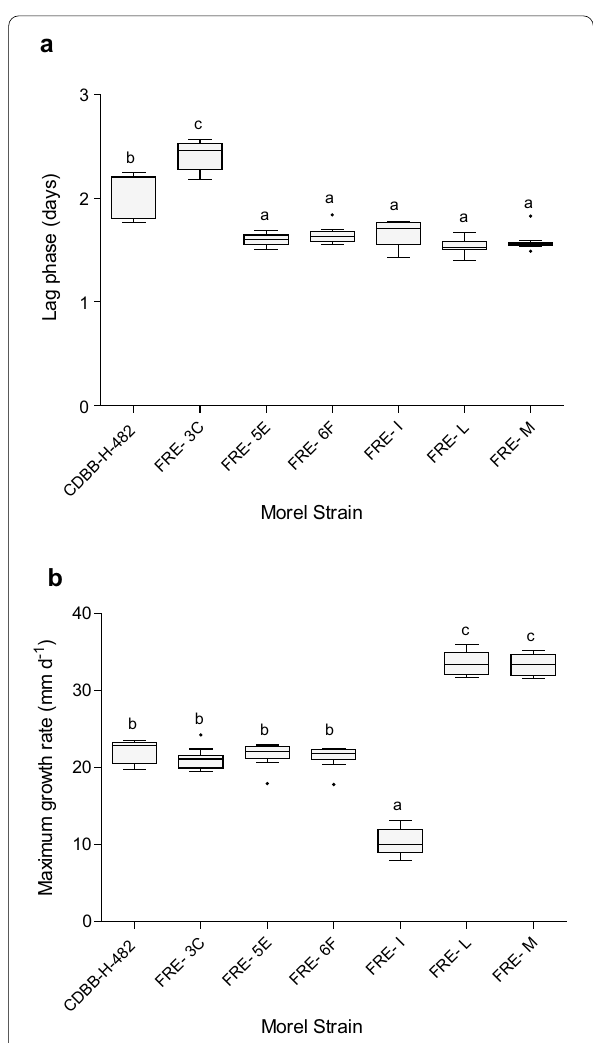
Fig. 5 a Lag phase of M. esculenta CDBB‑H‑482 and Morchella sp. wild isolates (FRE‑3C, FRE‑5E, FRE‑6F, FRE‑I, FRE‑L, FRE‑M) cultivated in MEA‑coconut. Different letters indicate significant differences according to Duncan test ( p < 0.05, n 10). b Growth rates of = Morchella spp. wild strains cultivated in MEA‑coconut. Different letters indicate significant differences according to Duncan test ( p <